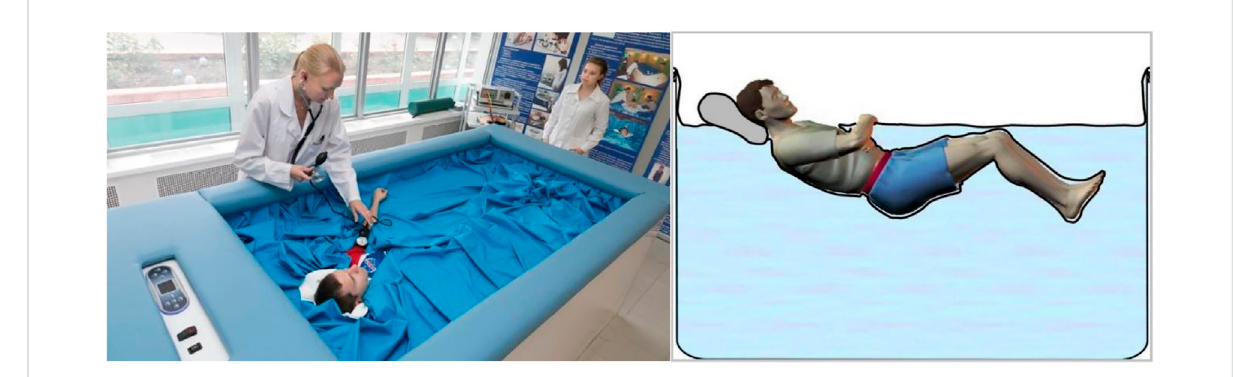
FIGURE 1 Left: Subject immersed in the Dry Immersion (DI) bath being separated from the water by non-elastic waterproof fabric (Image credit: IBMP press secretary Oleg Voloshin). Right: Schematic representation of the body posture in DI (Shulzhenko and Vil-Villiams, 1975).